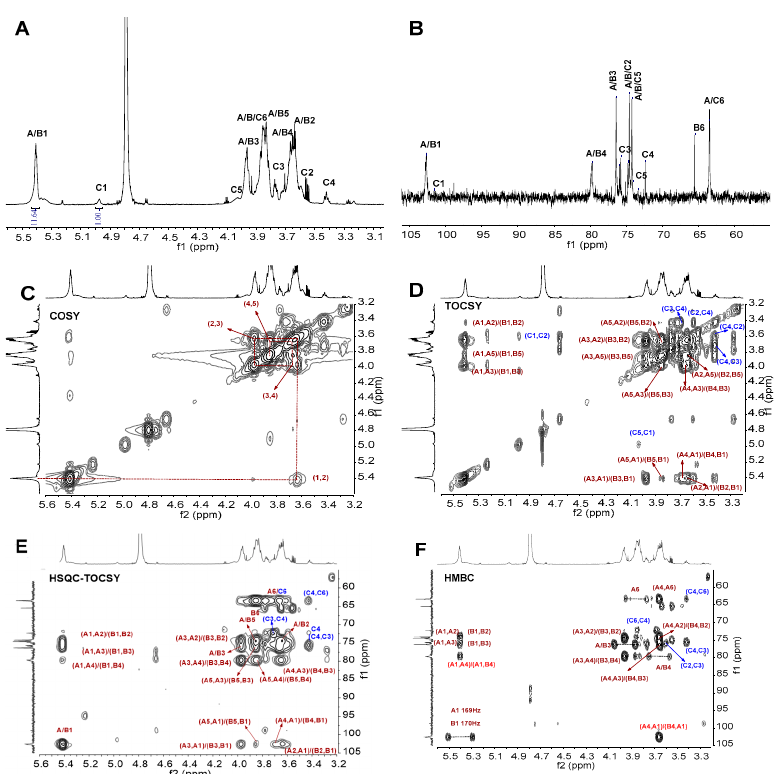
Figure 3. 1 H ( A ), 13 C ( B ), COSY ( C ), TOCSY ( D ), HSQC-TOCSY ( E ), HMBC ( F ) NMR spectra of BCG-2. Chemical shifts are relative to external trimethylsilylpropionic acid sodium at 0 ppm. The letters A/B (maroon) represented → 4)- α -Glc → 1 (residue A)/ → 4,6)- α -Glc(1 → (residue B). The letters C (blue) represented t- α -Glc (1 → (residue C). Table 2. 1 H and 13 C NMR chemical shifts of the BCG-1 and BCG-2 in D 2 O. Chemical Shifts Sugar Residues